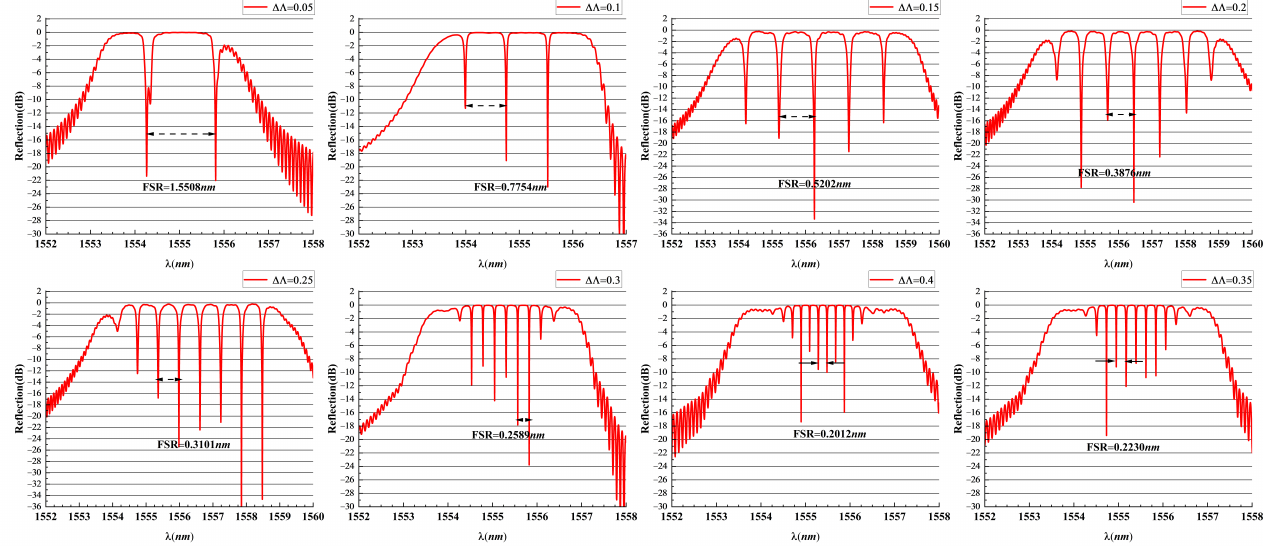
Figure 7. Reflection spectra for 2D chirped fiber gratings with different initial period